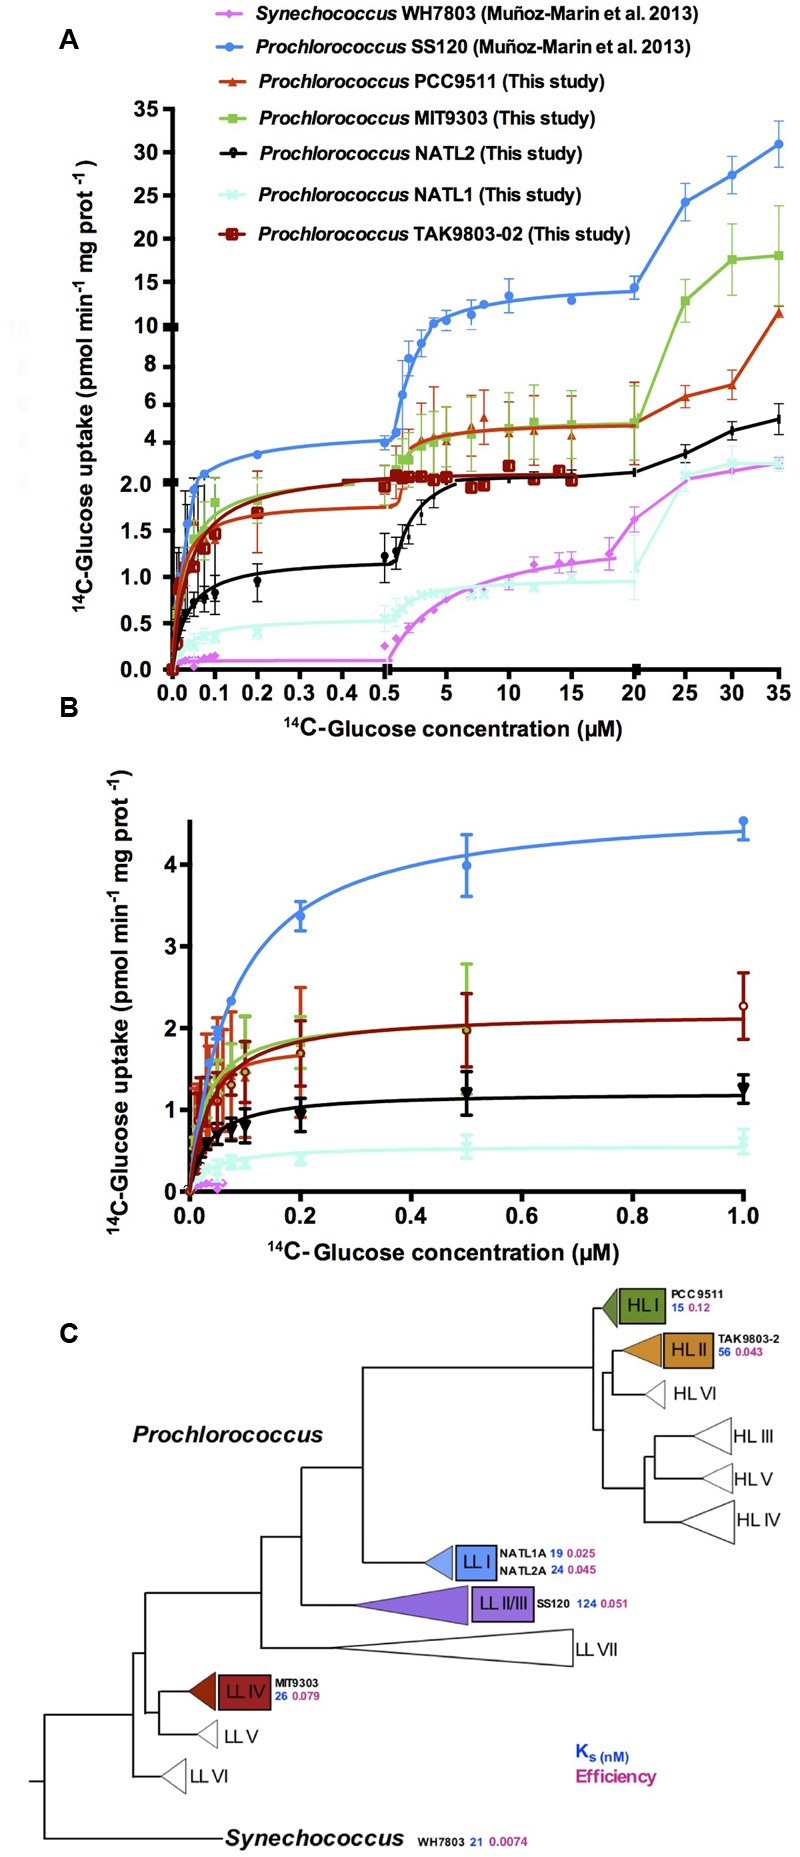
Kinetics studies of glucose uptake in Prochlorococcus sp. strains PCC 9511, MIT9303, NATL1A, NATL2A, and TAK9803-2. (A)
14C-Glucose concentration vs. 14C-glucose uptake. (B)
14C-Glucose concentration vs. its uptake with a different scale in the axis to allow a proper representation of the first phase of the kinetics. Previously described results for SS120 and WH7803 (Muñoz-Marín et al., 2013) are plotted in both graphs as a reference. Data presented are the average of at least three independent biological replicates. Bars show standard deviation for each sample. (C) Simplified phylogenetic tree of marine picocyanobacteria based on the rRNA internal transcribed spacer [ITS; adapted from that published by S. W. Chisholm and coworkers (Biller et al., 2015)] showing the evolution of glucose uptake. Numbers next to the name of each strain show the GlcH transporter Ks value (in blue), followed by the efficiency of glucose uptake in pink (as shown in Table 2).